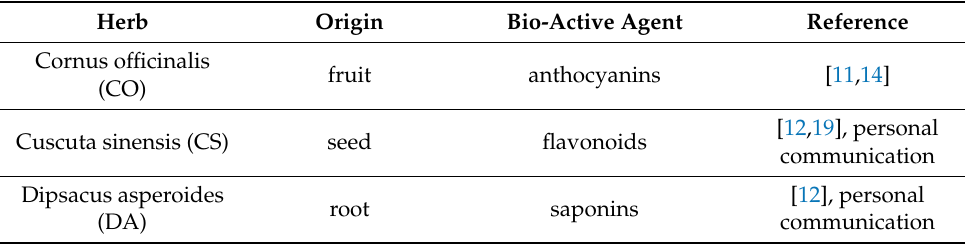
Table 2. Chinese herbs screened in the TNBC